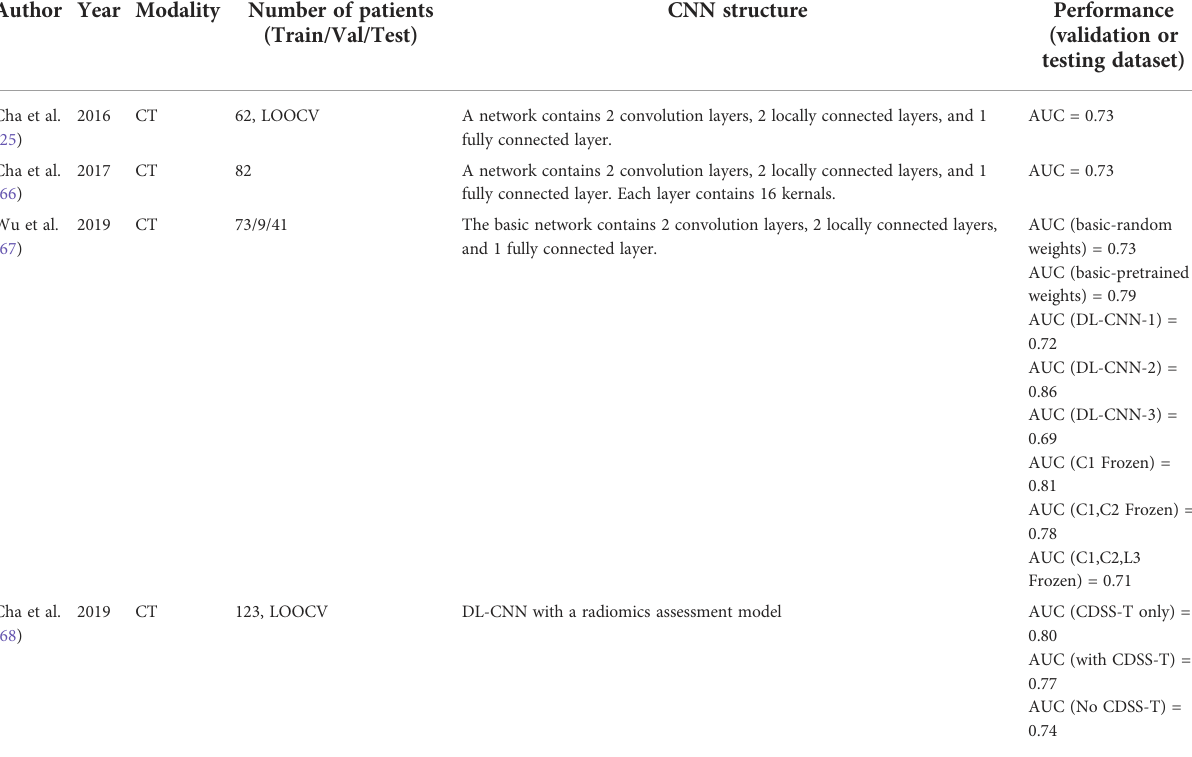
TABLE 3 Studies using deep learning approach for bladder cancer